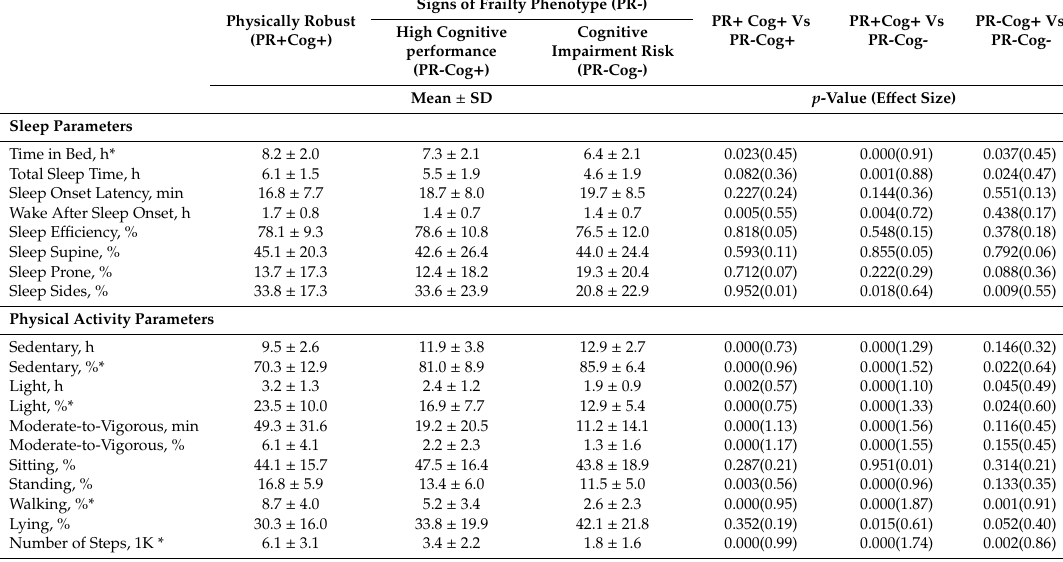
Table 3. Mean and standard deviation of sensor-derived parameters and comparison of the four aging trajectories.